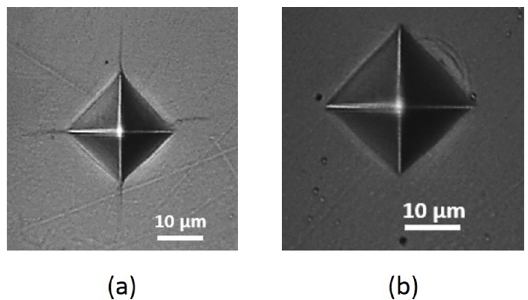
Figure 4. (a) Indentation mark at the 2 mm diameter (bottom part) rod, showing the presence of Palmqvist cracks. (b) Shear bands (SBs) formation around the indentation at the 1 mm diameter rod (bottom). SBs are typically formed during deformation of metallic